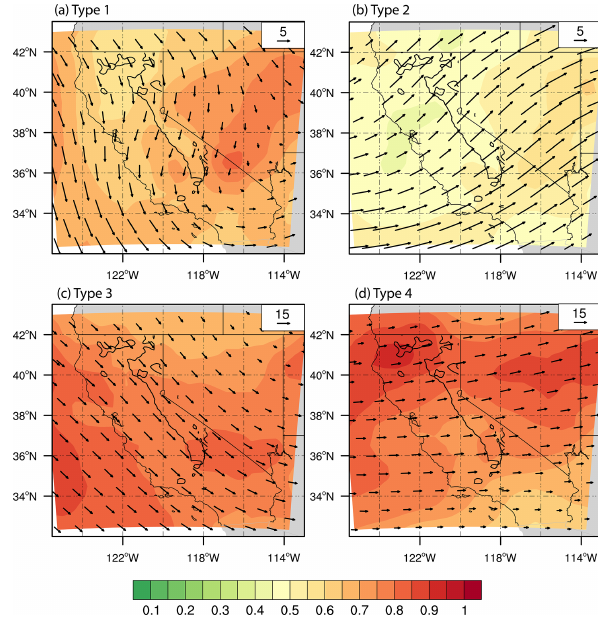
Figure 12. Mid-level (200–700hPa average) dust concentration (ugm − 3 ) and dust transport fluxes (µm − 2 s − 1 ) in each of the four SOM types from MERRA-2 for the year